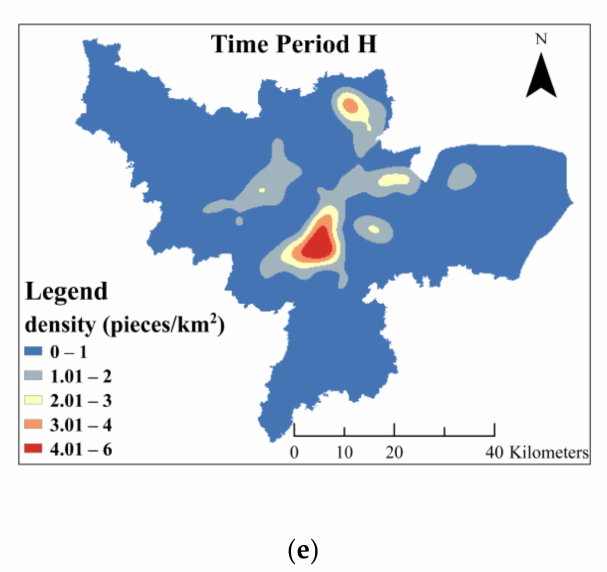
Figure 6. Density of changed street names in time periods. Panels ( a – e ) correspond to time periods D–H, respectively. With the passage of time, the spatial characteristics of changed street names present two obvious characteristics. The changed street names continued to expand to the periphery of the city from the old urban zone. With the expansion of the changed street names, the density peak area appears in the suburban zones. However, the density values are obviously reduced compared with the old urban zones. This reflects that urbanization has changed from the tight and dense mode to the extensive and sparse mode. Combined with the types of changed street names (Figure 7), we analyzed the focus locations of road construction and urban sprawl in the time periods D–H.